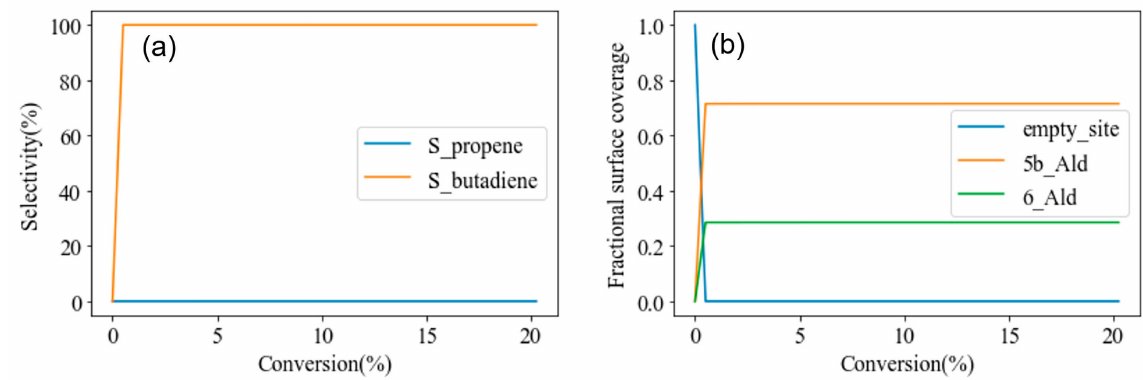
Figure 3. Microkinetic analysis of the dry-Al 2 O 3 model. ( a ) Selectivity for butadiene and propene as a function of conversion. ( b ) Surface coverage in predominant species as a function